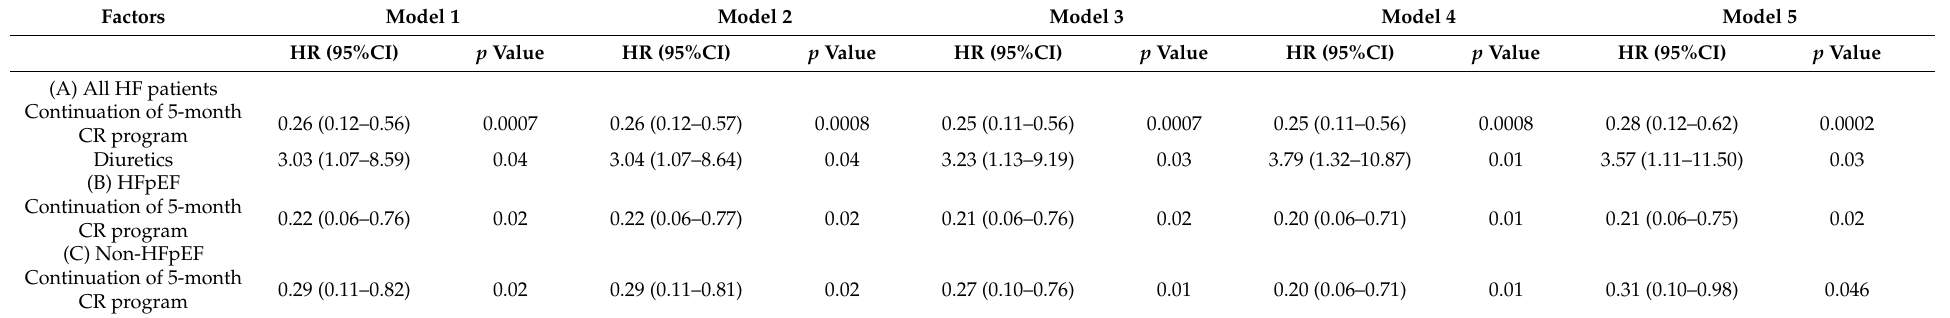
Table 5. The relationship between all-cause death and hospital admissions and its associated factors for continuation of 5-month CR program and in 5-month period in all HF patients (A) and HFpEF (B) and non-HFpEF (C) groups, analyzed by a multivariate logistic regression